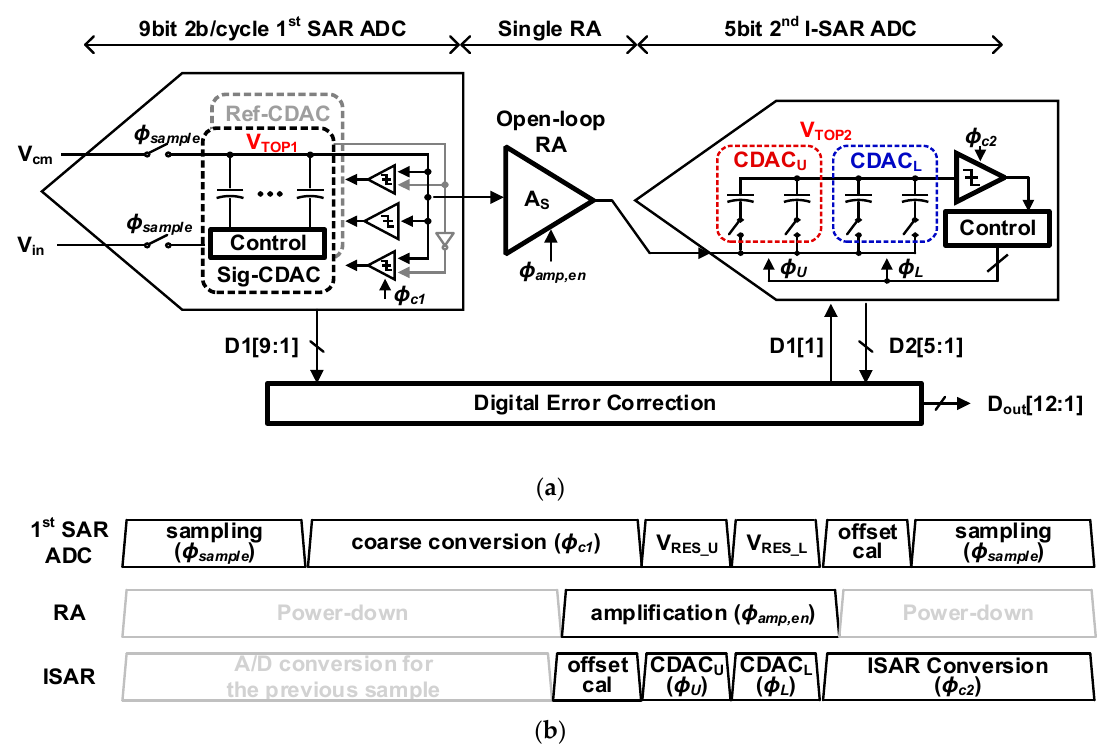
Figure 12. ( a ) Architecture for the prototype ADC with the proposed techniques; ( b ) Timing diagram. Reprinted with permission from Ref. [22]. Copyright 2019 the Japan Society of Applied Physics.